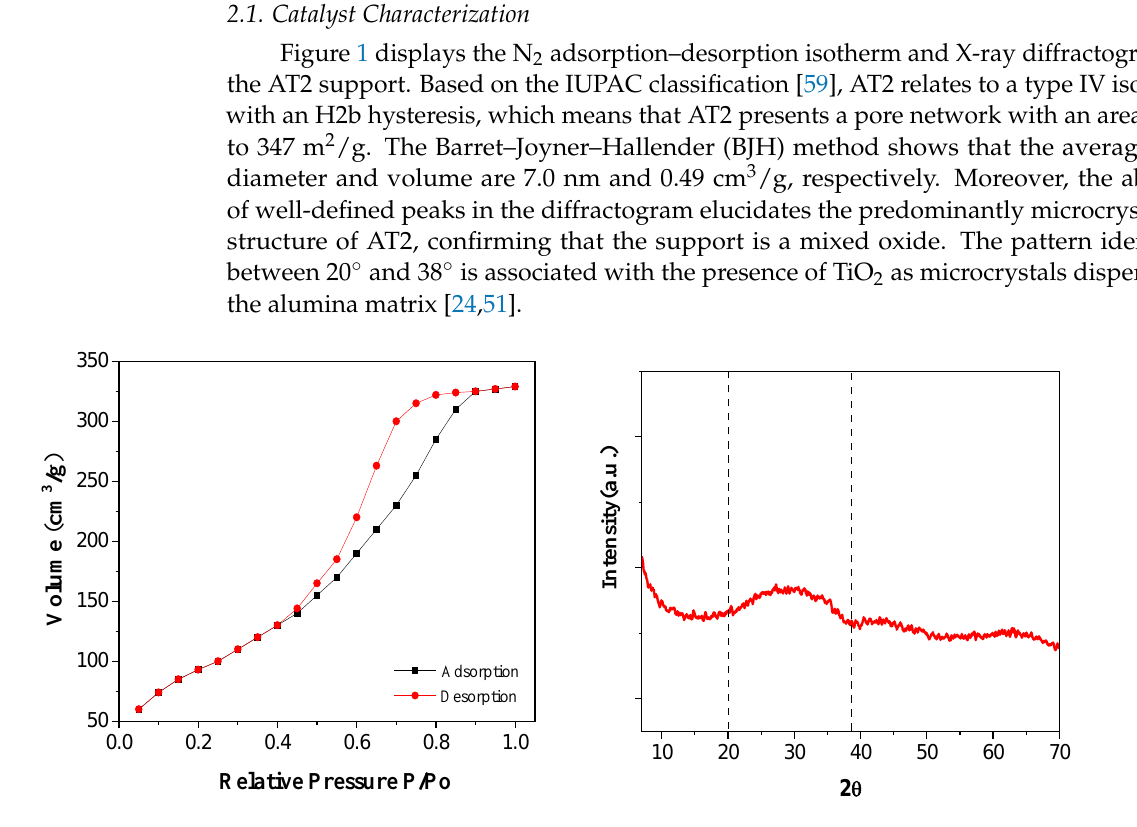
Figure 1. N 2 adsorption–desorption isotherm ( left ) and X-ray diffractogram ( right ) for the support Figure 1 . N 2 adsorption – desorption isotherm ( left ) and X-ray diffractogram ( right ) for the support Al 2 O 3 -TiO 2 (AT2). Al 2 O 3 -TiO 2